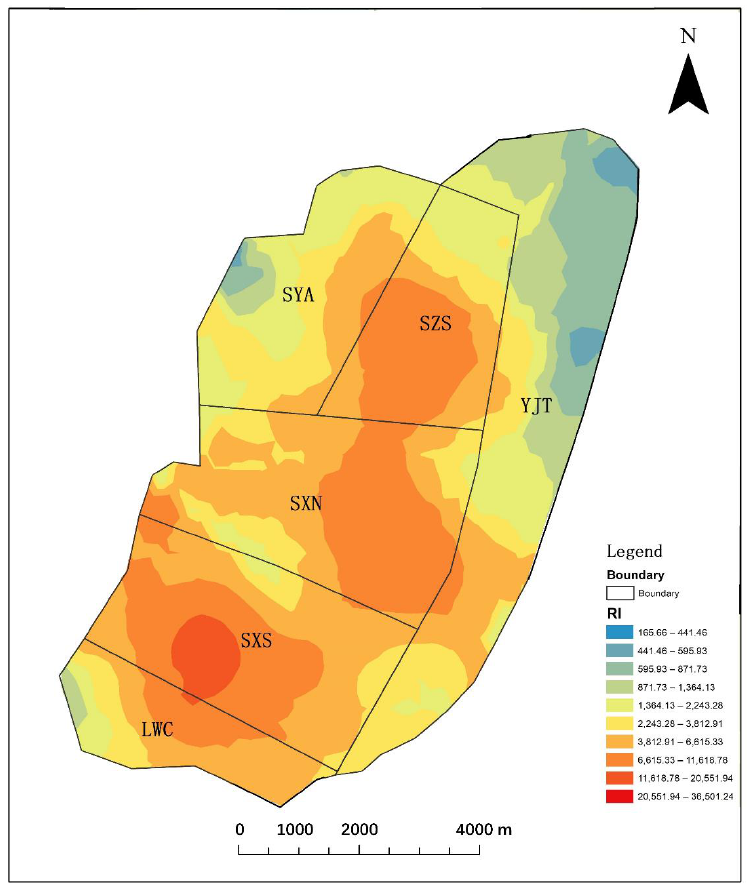
Figure 4. Spatial distribution of potential ecological risk index of PTEs from the six sampling sites.